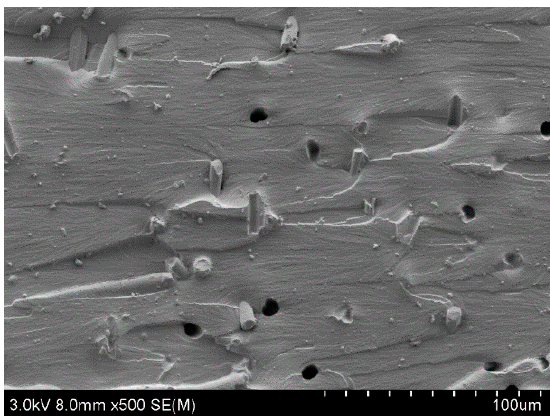
Figure 9. Tensile fracture cross-section of the X–Y polylactic acid–carbon fiber specimen. 189